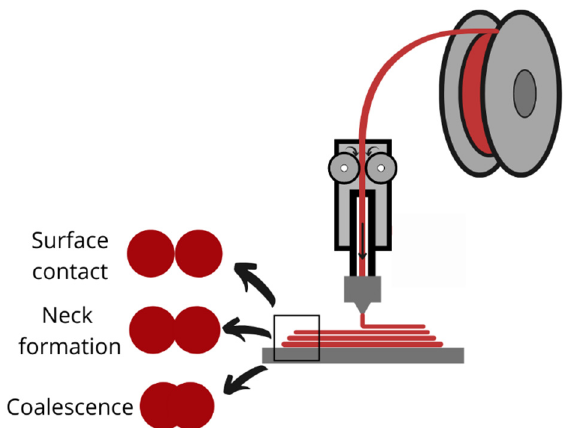
Figure 15. Layer interfacial bonding